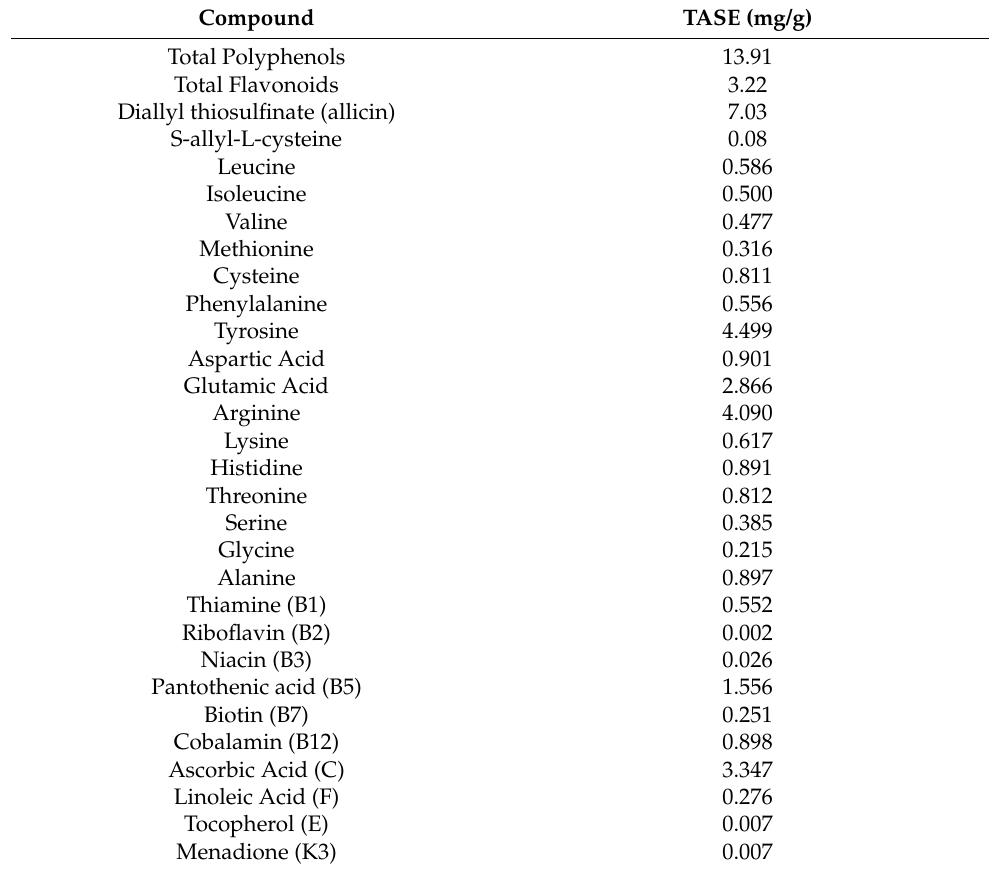
Table 2. Composition of organic compounds of lyophilized thiosulfinate-enriched Allium sativum extract (TASE) from purple garlic of Las Pedroñeras (Cuenca, Spain) used in this